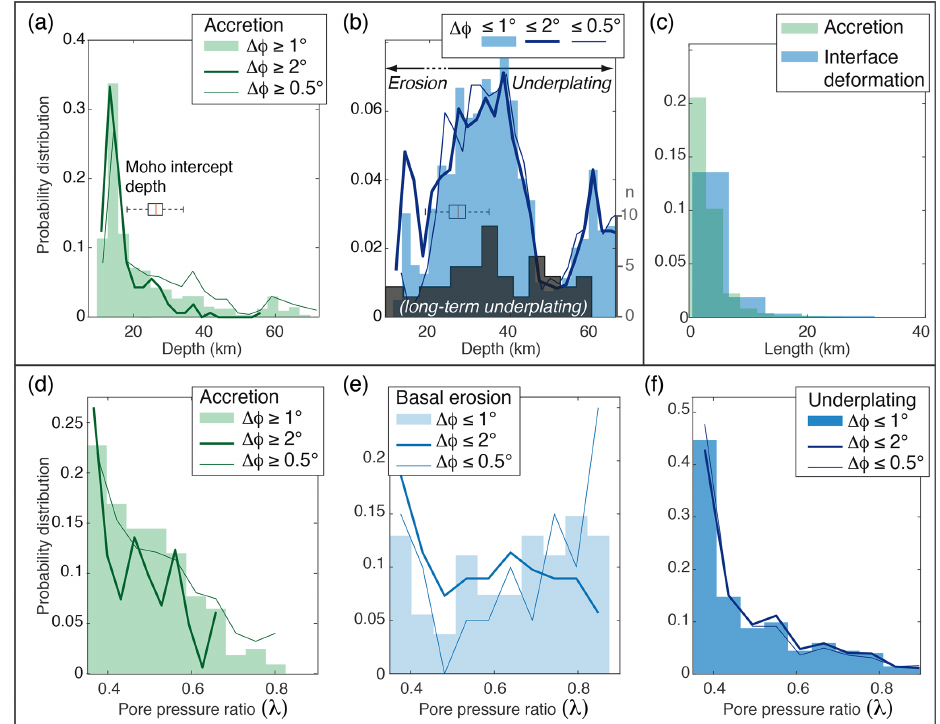
Figure 4. (a) Mean depth of segments at accretionary critical state and (b) distributed plate interface deformation critical state, compared to a compilation of the maximum burial depth reached by exhumed tectonic slicing (grey; Agard et al., 2018), and to the box plot of the Moho intercept depth (Tassara and Echaurren, 2012). (c) Length of segments at accretionary and distributed plate interface deformation critical state. (d) – (f) Pore fluid ratio λ of segments at accretionary, basal erosion and underplating critical state, assuming that basal erosion prevails above 20km depth, and underplating below. Histogram curves are shown for a 1 ◦ difference of internal and basal effective friction, thin line for a 0.5 ◦ difference and bold line for 2 ◦ (curves were chosen for sake of